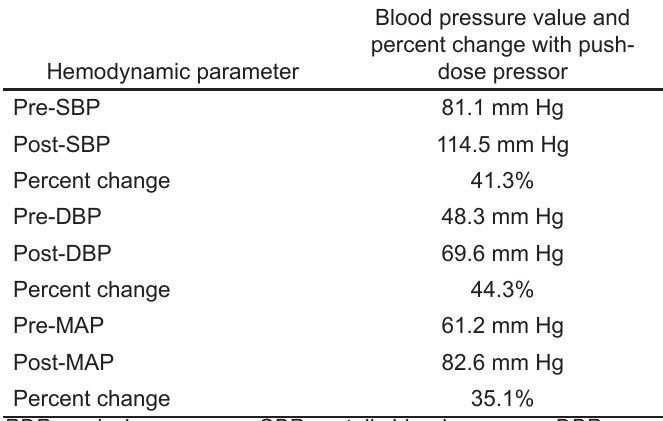
Table 3. Overall mean hemodynamic parameters (before and after PDP*) with mean percent